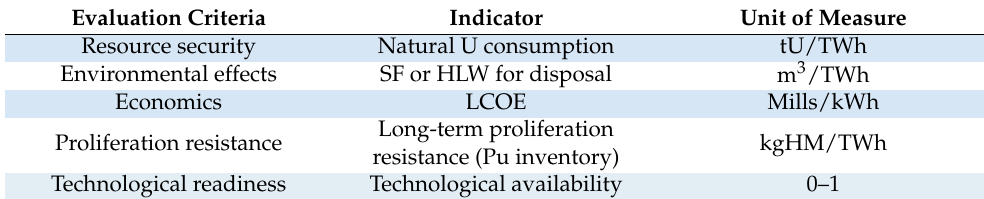
Table 11. Evaluation criteria from Gao and Ko [72].